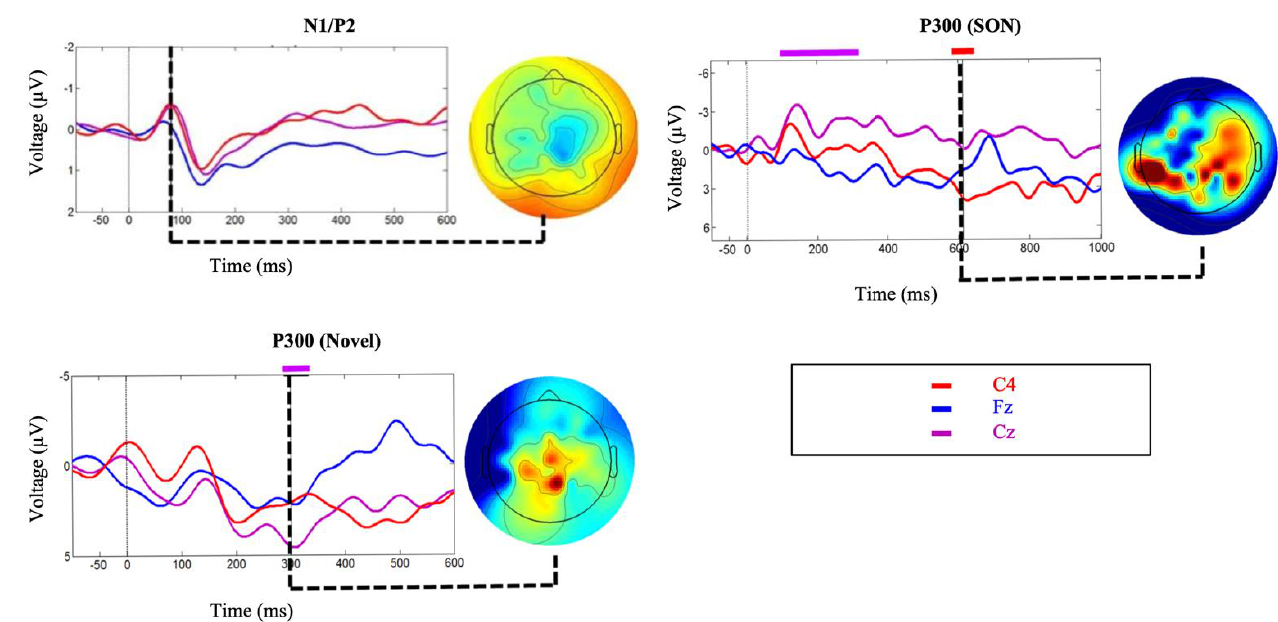
Figure 7. Event related potentials corresponding to Case Study 3. Exogenous ERPs were observed (overlaid on participant averages) in response to the standard tone of the Modified Fischer paradigm (N1/P2). Significant differences were observed (overlaid on participant averages) for brain responses to novel stimuli and SON as part of the Modified Fischer paradigm. Topographic maps at each point of significance show dominant activity in the posterior areas of the brain, decentralized, as typical of many brain-injured individuals. Figure 7 has been adapted from Blain-Moraes et al. 2016, “Figure 2” [69] and is licensed under the CC BY 4.0 (https://creativecommons.org/licenses/by/4.0/. Accessed on: 27 April 2017).